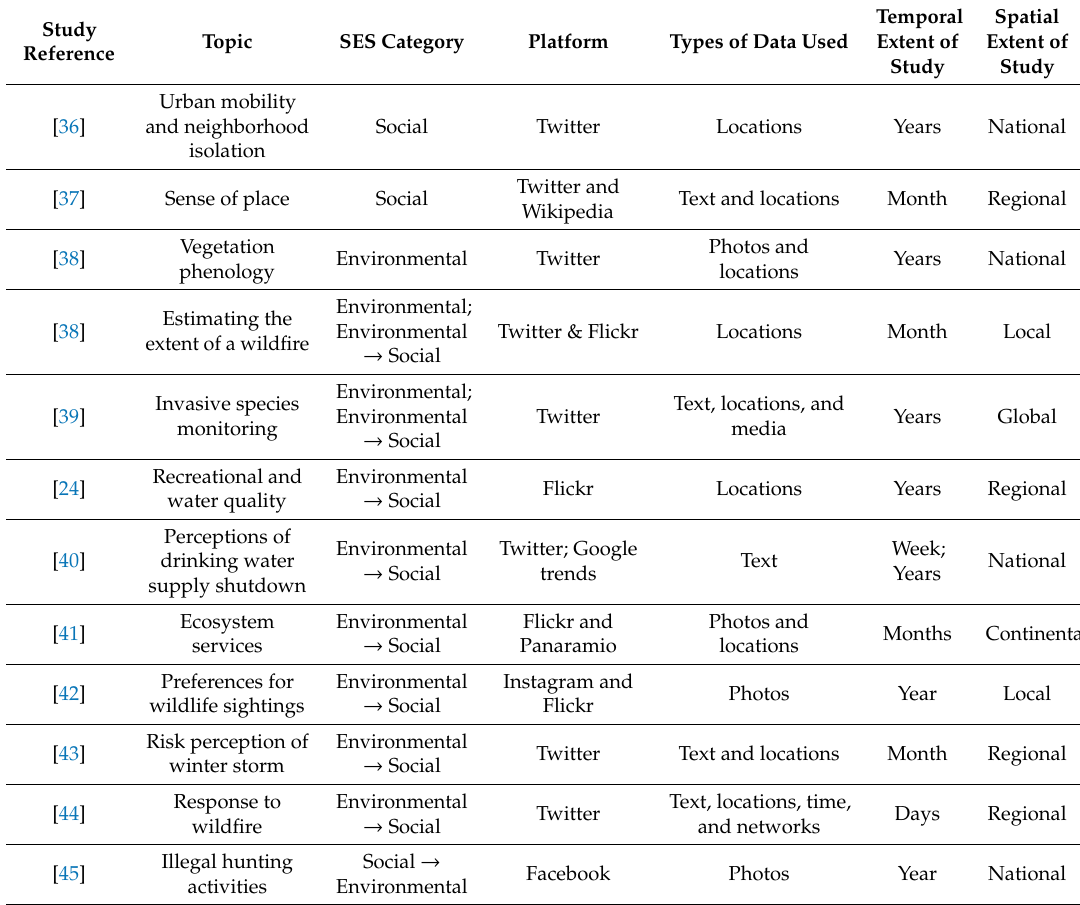
Table1. ExamplesofstudiesfallingintothefourcategoriesofSES(Social, Environmental, Environmental → Social, Social → Environmental) with information on the study topic, the social media platforms and data types used, and the spatial and temporal extent of the